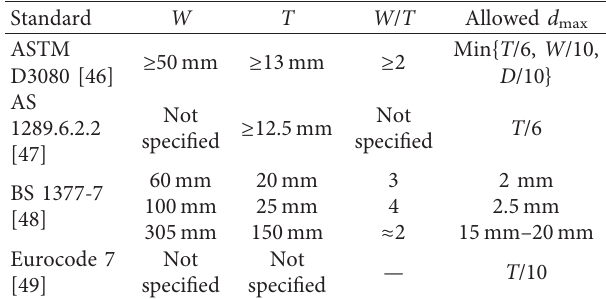
Table 1: Standards of direct shear tests regarding the maximum allowed particle size ( d max ), specimen width ( W ), thickness ( T ), and diameter ( D